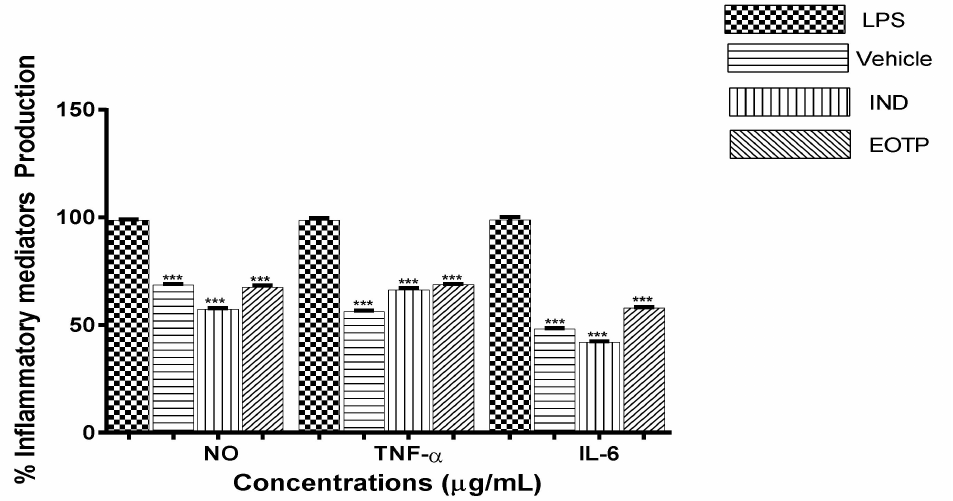
Figure 1. Effect of EOTP on the levels of NO, TNF- α , and IL-6 in macrophages stimulated with LPS. The results are the mean of three determinations ± SEM. *** p < 0.001 vs. vehicle. EOTP inhibited the production of the pro-inflammatory cytokines TNF- α (69.21%) and IL-6 (58.44%) in LPS-stimulated macrophages. TNF- α is involved in the acute